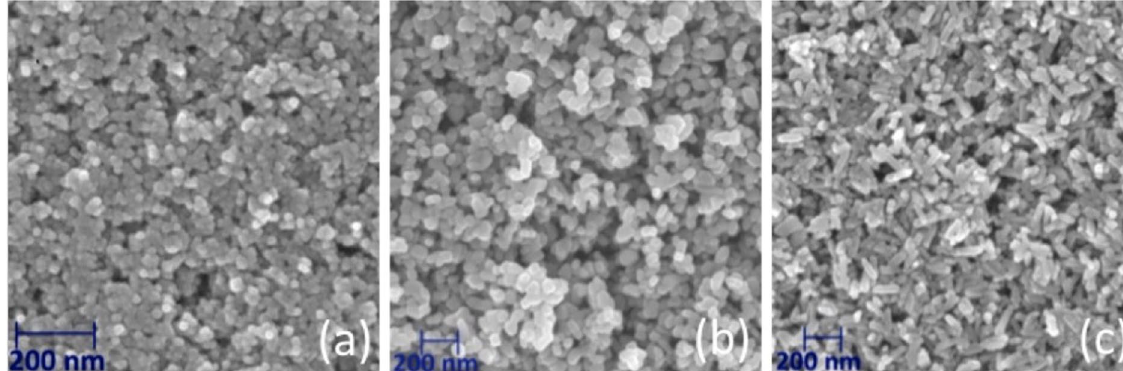
Figure 1. Top-down SEM images of mesoporous ( a ) anatase, ( b ) rutile and ( c ) brookite films on FTO (1.6 ± 0.6 nm) matches literature values for the hole diffusion length (1–10 nm) 22 . In addition, work within our